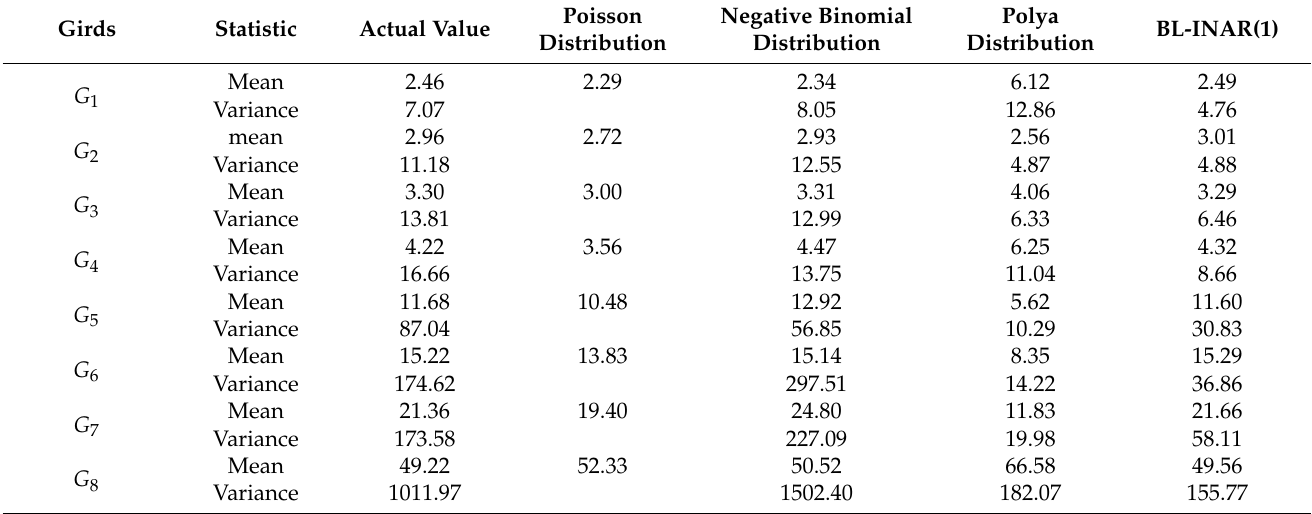
Table 2. The mean and variance of tornado frequency of partial grids under different